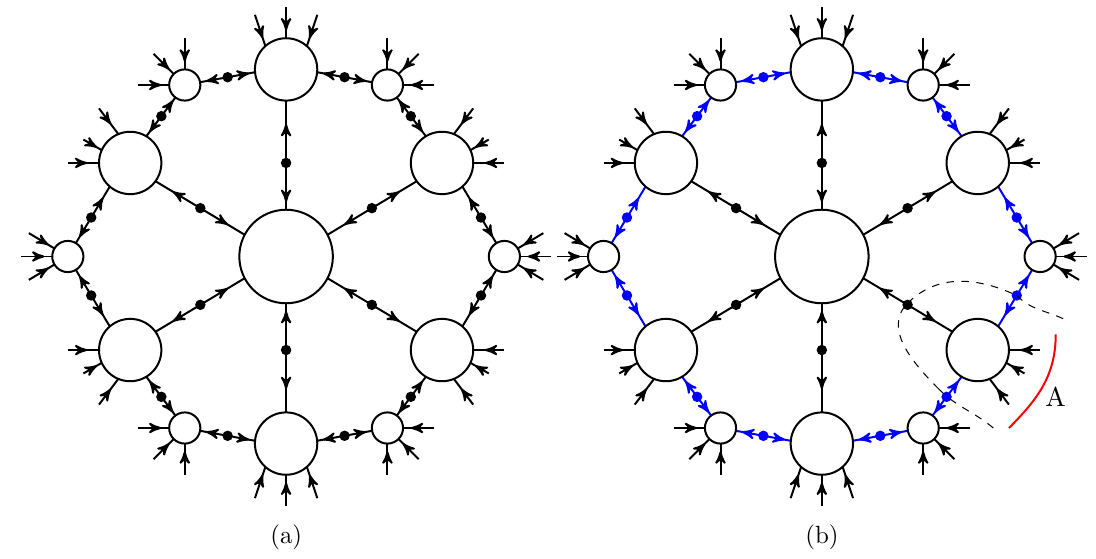
Figure 8. (a) A HaPPY network. Six legged vertices are perfect tensors and two legged projecting pairs are maximally entangled states. All boundary entropies are given by the graph length of a minimal cut in the network. (b) A network which satisfies the Ryu-Takayanagi formula using the mutual information based definition of length, but does not satisfy Ryu-Takayanagi when using the graph length. The blue dots and legs represent the projecting state given in eq. (3.11). The dashed line represents the isometric cut for the boundary region A .